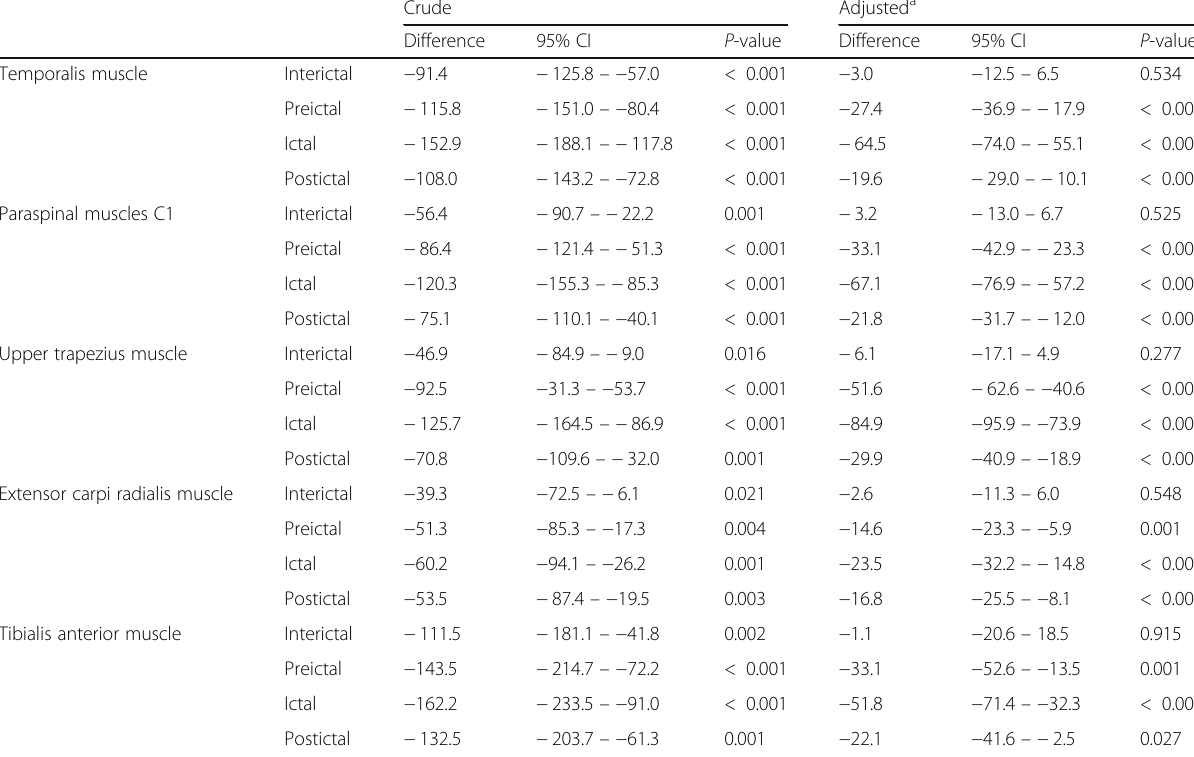
Table 3 Differences in pressure pain thresholds between people with migraine and healthy participants (dominant